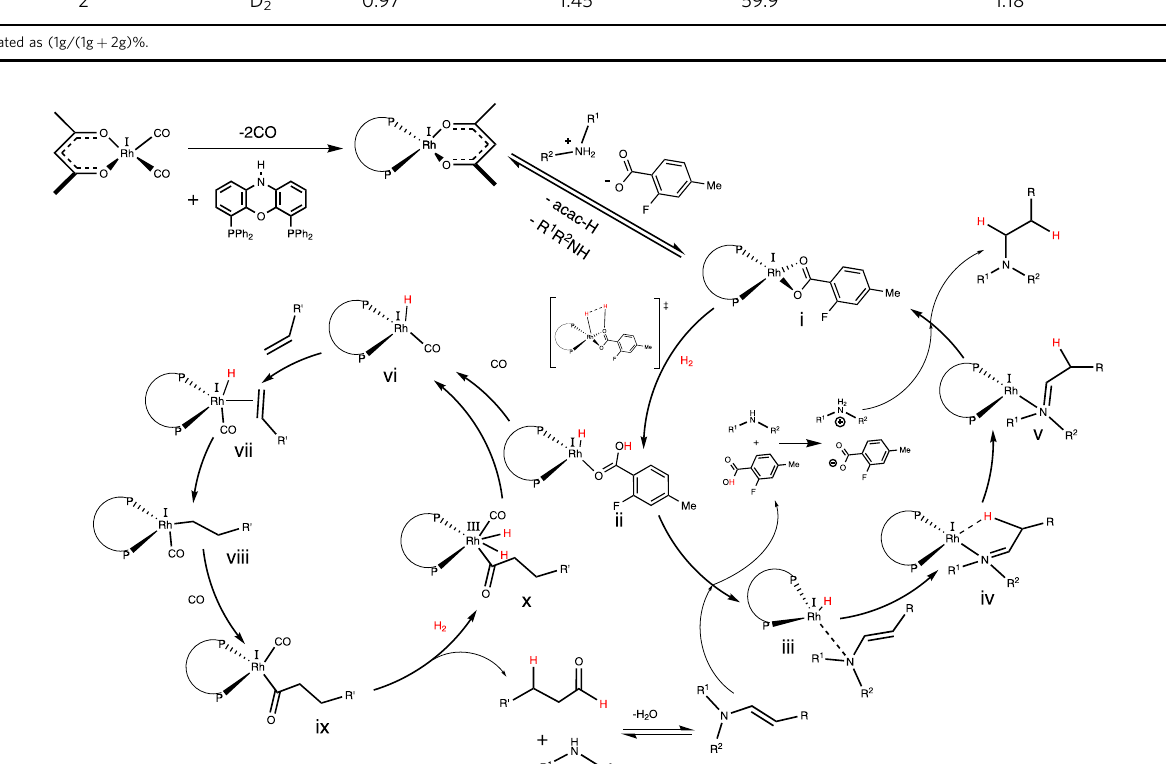
Fig. 7 Proposed reaction mechanism. Proposed mechanism of the HAM reaction with the cooperative catalyst developed in this